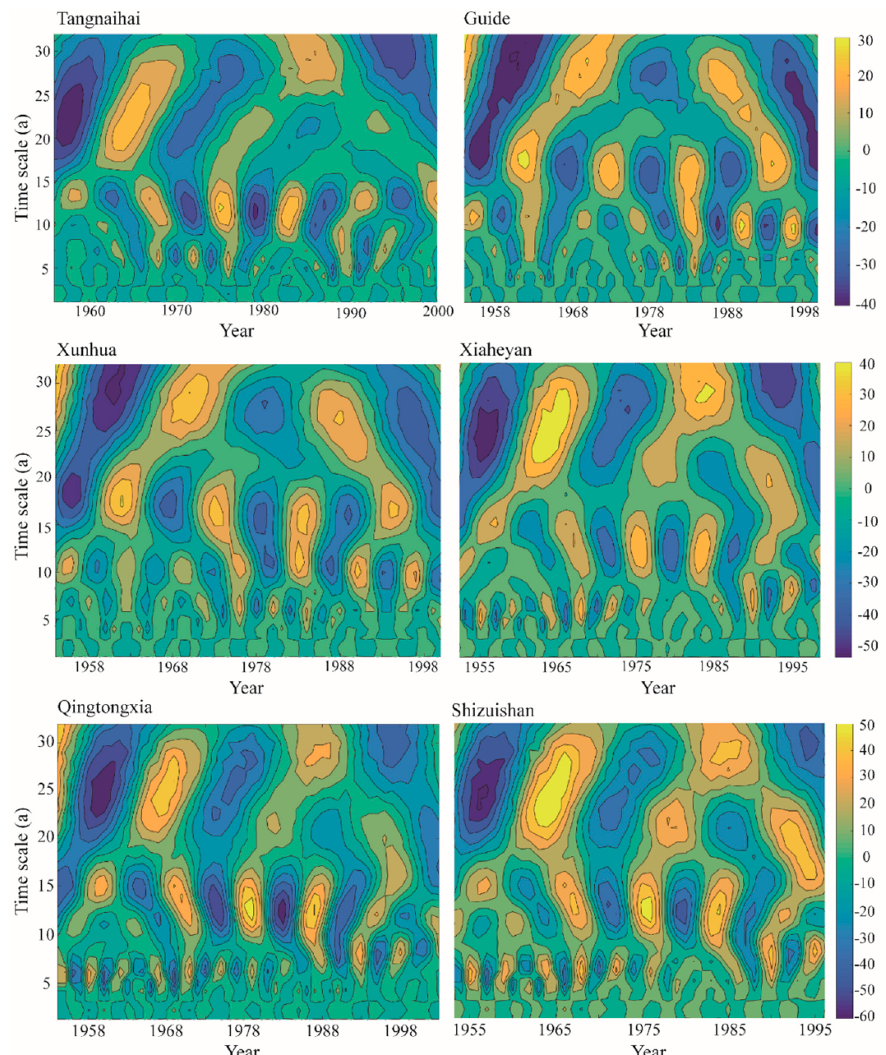
Figure 7. Wavelet analysis of the baseflow time series at the six hydrological stations.